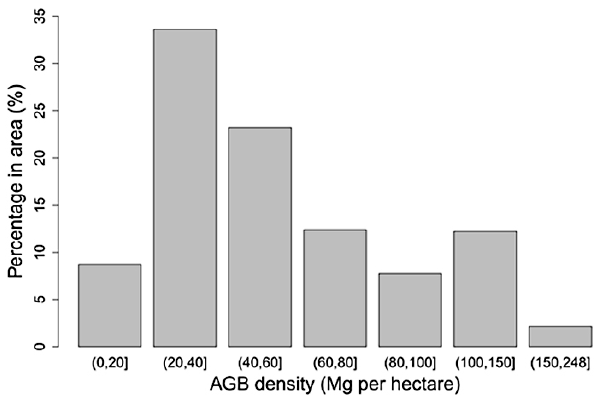
Figure 4. Histogram of forest AGB density based on the estimate of decision-tree-based modeling.